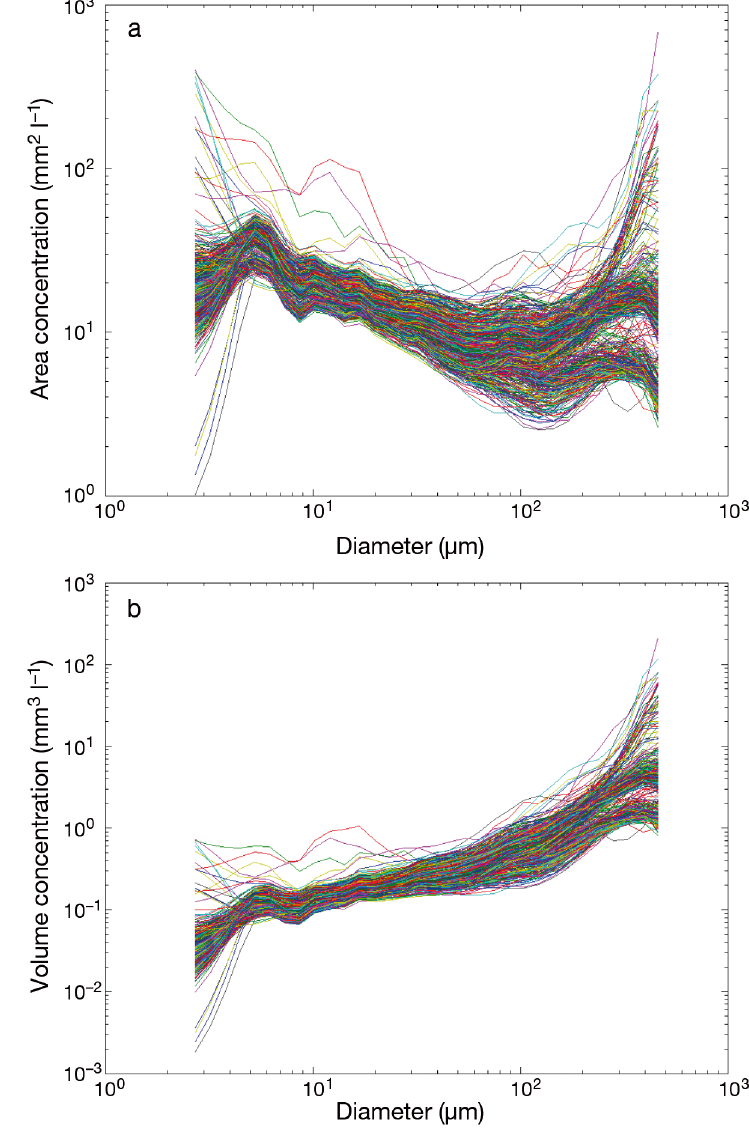
Fig. 3. LISST 100X particle size distributions for both (a) area concentration and (b) volume